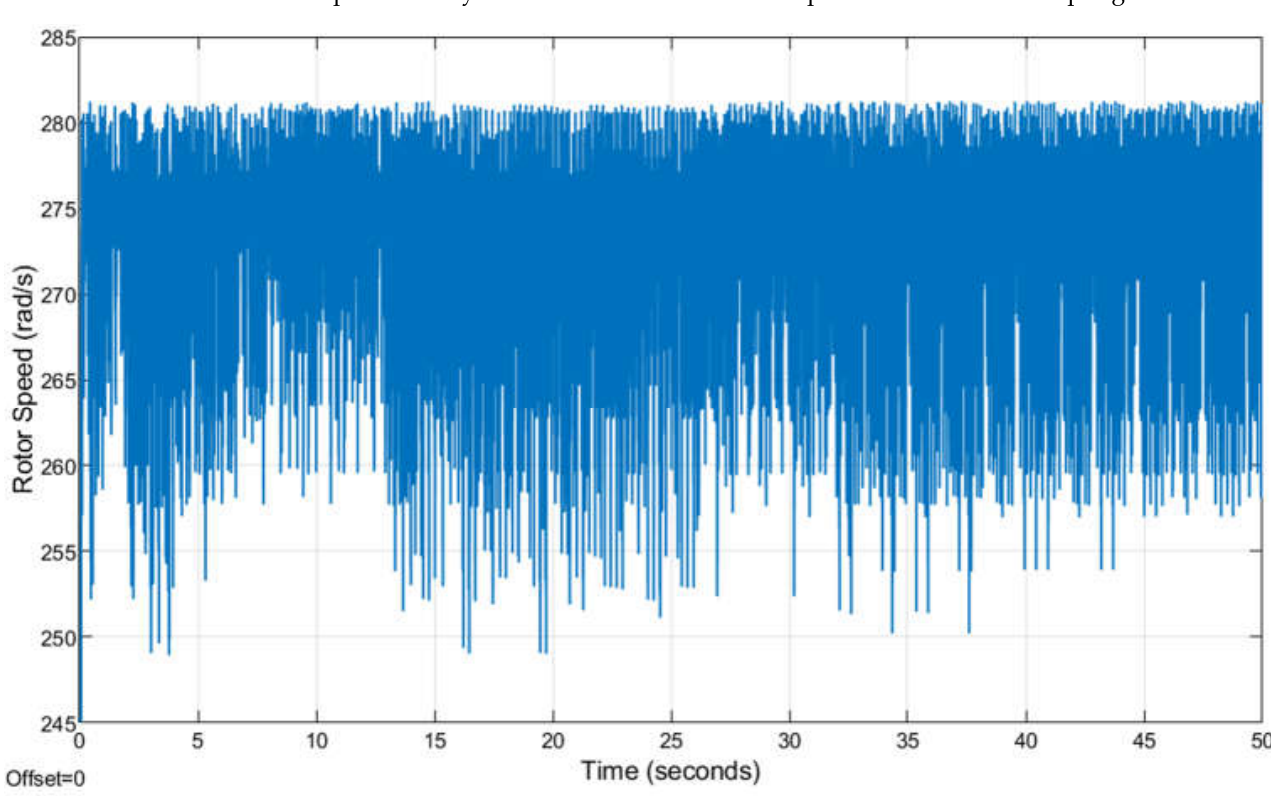
Figure 11. Applied reference rotor speed. Training data are collected from the Simulink model of the IM drive.